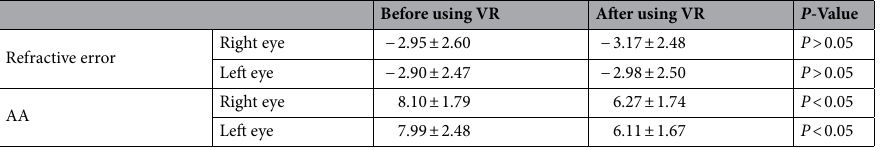
Table 1. The Refractive error and amplitudes of accommodation changes, in unit D, before and after the use of VR for watching 3D videos.